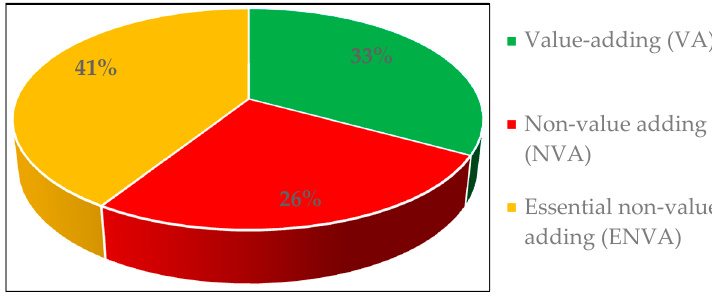
Figure 6. Average of each activity classification type for all observed construction processes.